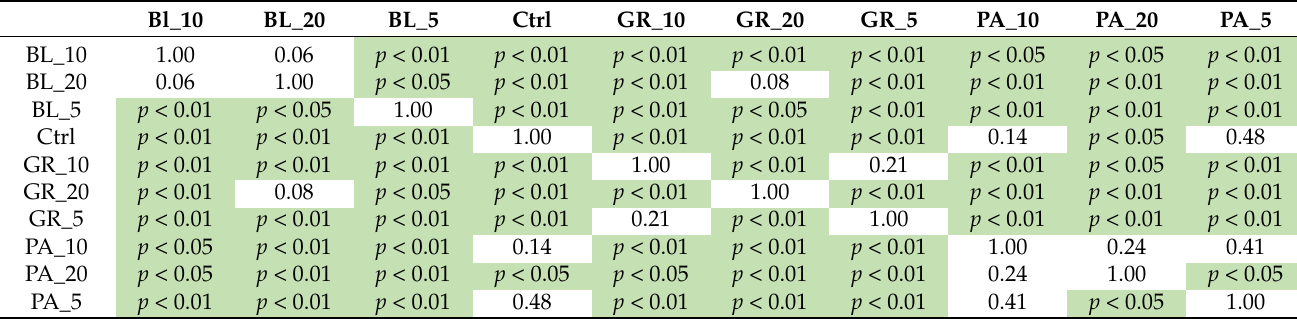
* Statistically significant differences between the groups are emphasized with green colour. BL_5, edible film with 5% of blueberry extract; BL_10, edible film with 10% of blueberry extract; BL_20, edible film with 20% of blueberry extract; GR_5, edible film with 5% of red grape extract; GR_10, edible film with 10% of red grape extract; GR_20, edible film with 20% of red grape extract; PA_5, edible film with 5% of parsley extract; PA_10, edible film with 10% of parsley extract; PA_20, edible film with 20% of parsley extract; Ctrl, control = edible film without added